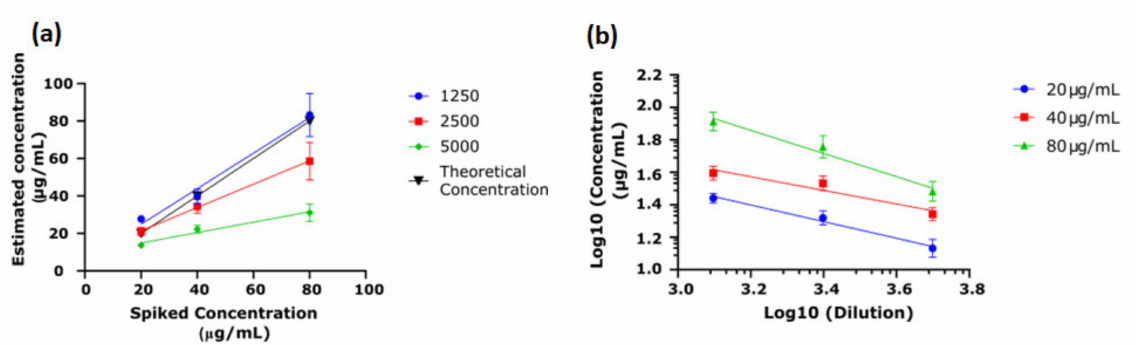
Figure 2. Validation of C9 direct ELISA. His-C9 was expressed and purified for use as the standard, and serum purified C9 was spiked into C9-depleted serum at three concentrations (20 µ g/mL, 40 µ g/mL and 80 µ g/mL). ( a ) Concentration estimated by the ELISA was plotted against the spiked concentration. Dilutions of 1/1250 predicted the theoretical concentration accurately while higher dilutions underestimated the theoretical concentration when samples were spiked at 40 µ g/mL and 80 µ g/mL ( n = 3). ( b ) Parallelism was determined by log10 calculation of dilution vs. estimated concentration of the spiked sample, demonstrating proportionate estimates of concentration at differing dilutions ( n =